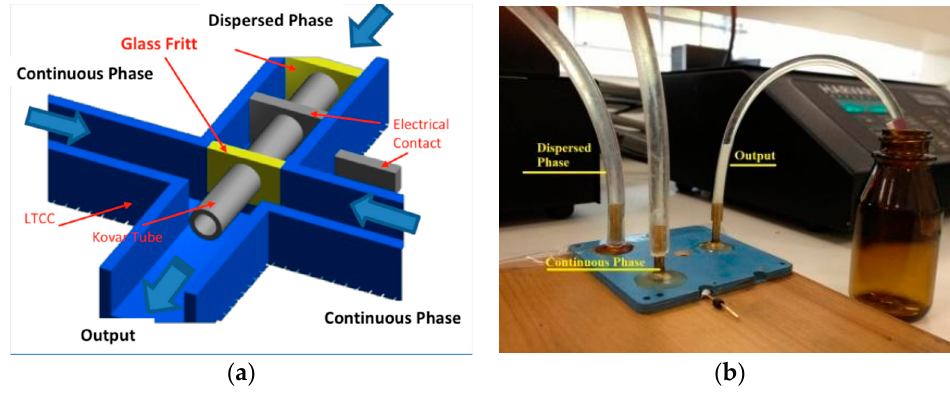
Figure 2. Coaxial flow focusing device: ( a ) cross section with Kovar tube to allow coaxial structuring and ( b ) the complete Flow Focusing Device in 3D configuration (3D-FFD) in operation.